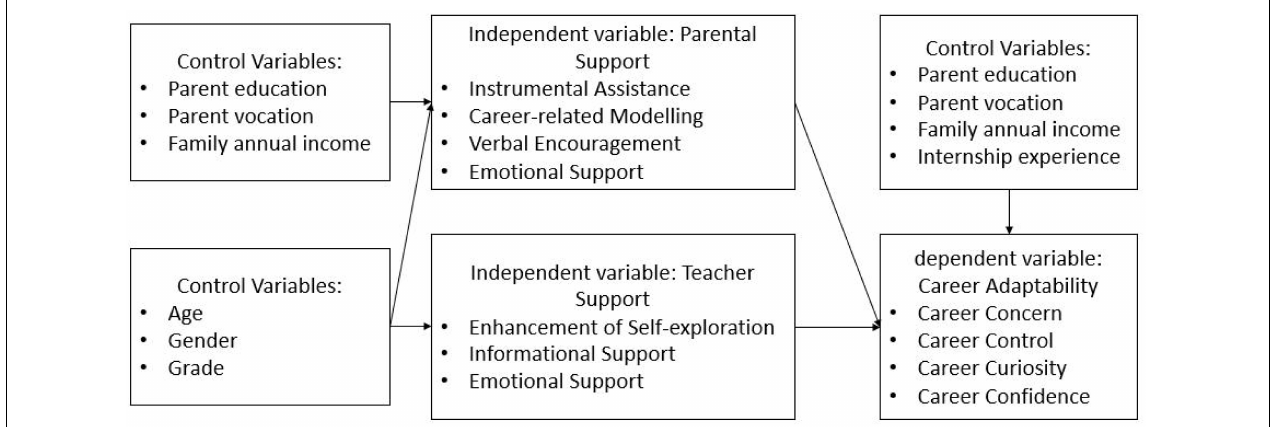
FIGURE 1 | Theoretical